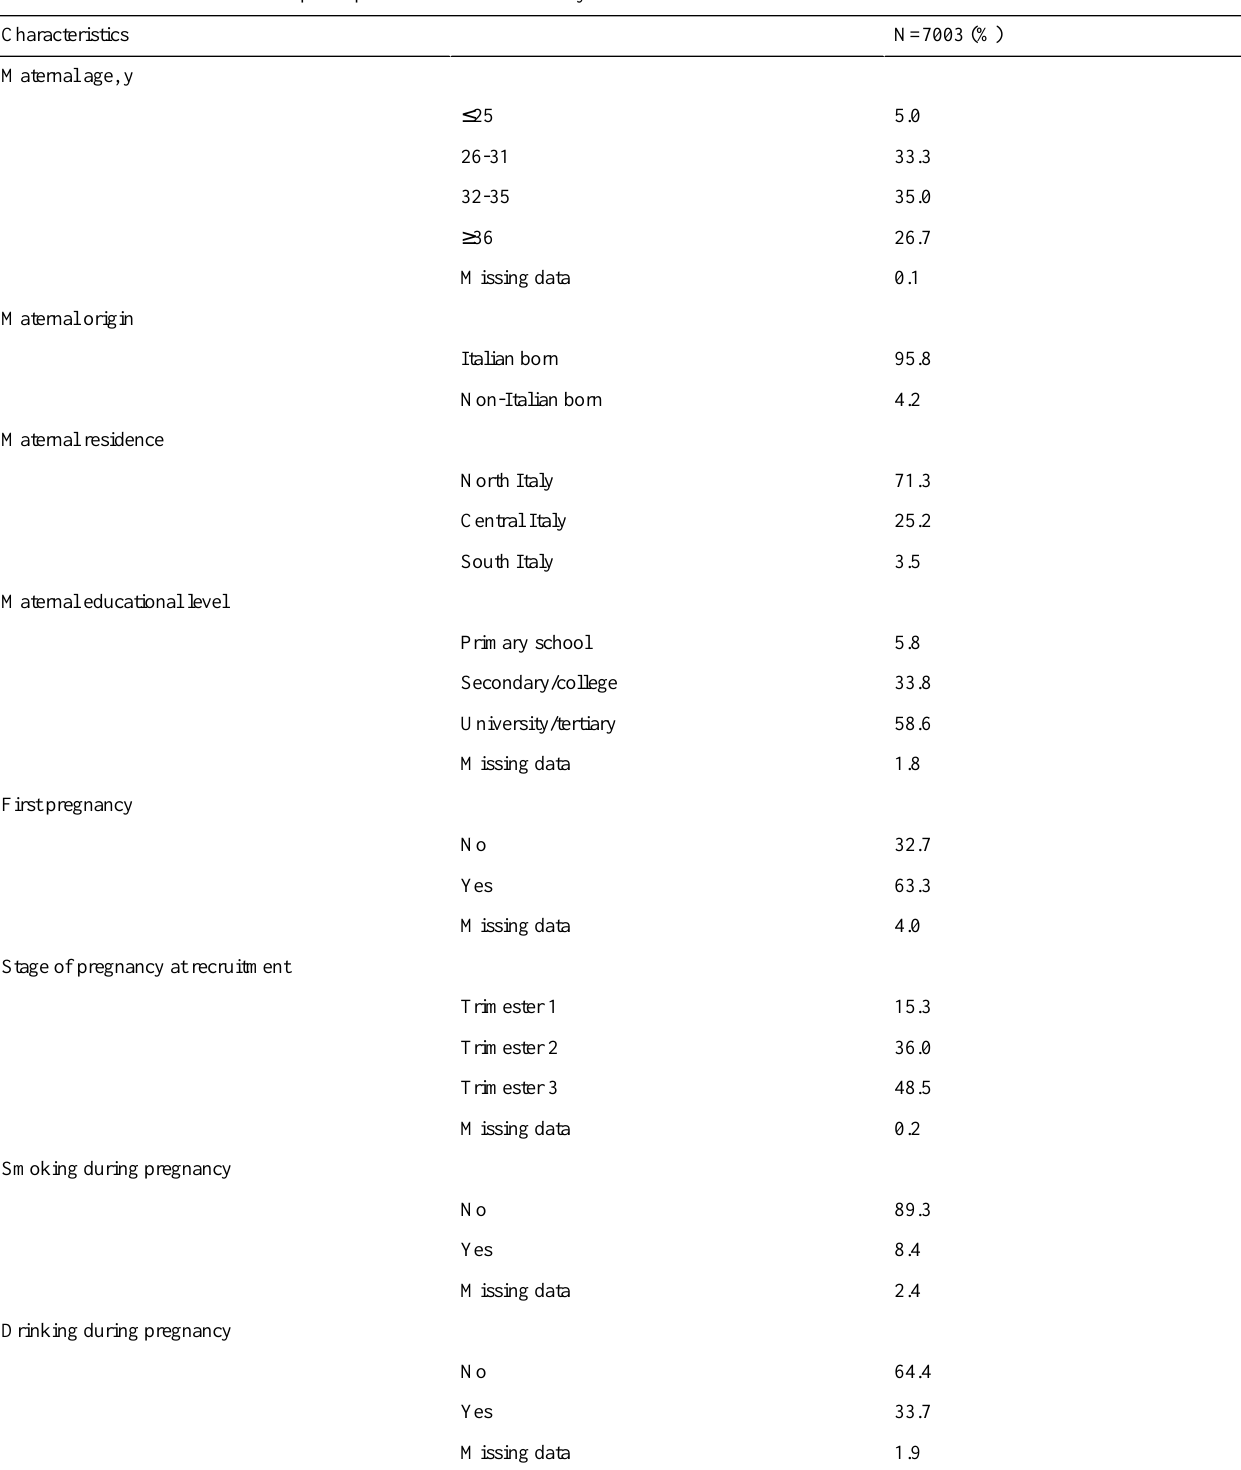
Table 2. Selected characteristics of participants in the NINFEA study a